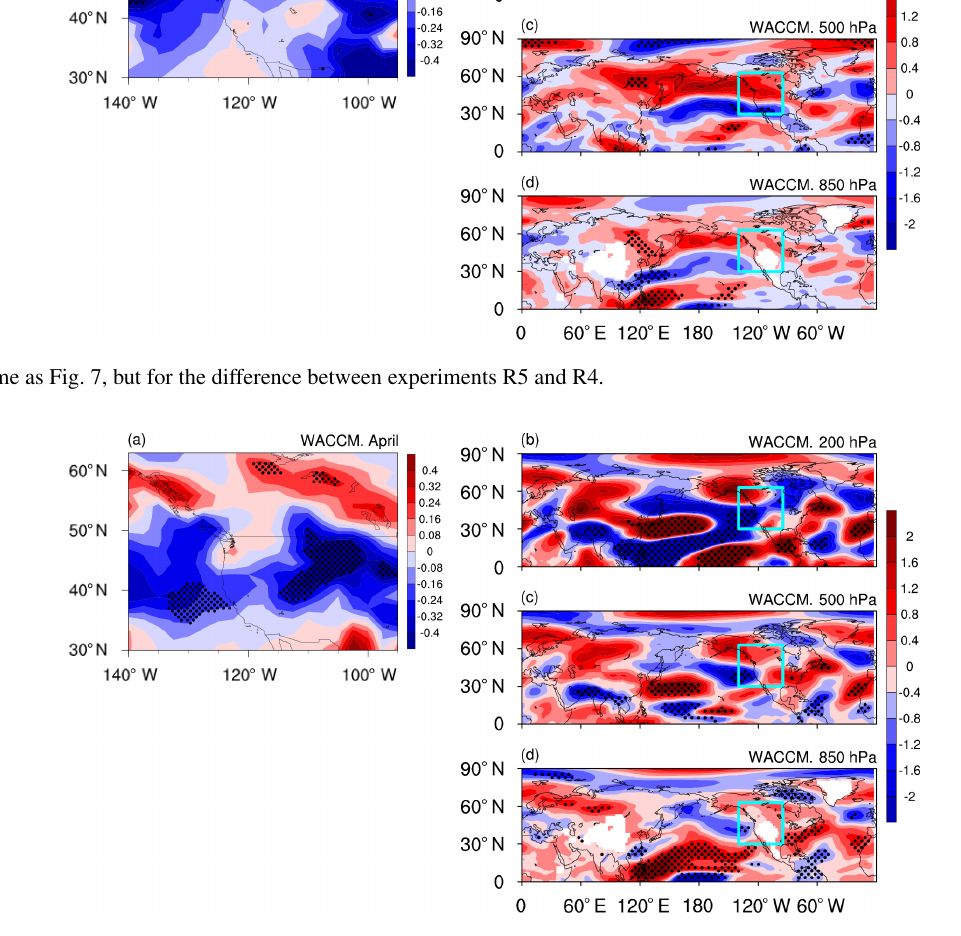
Figure 11. Same as Fig. 7, but for the difference between experiments R7 and